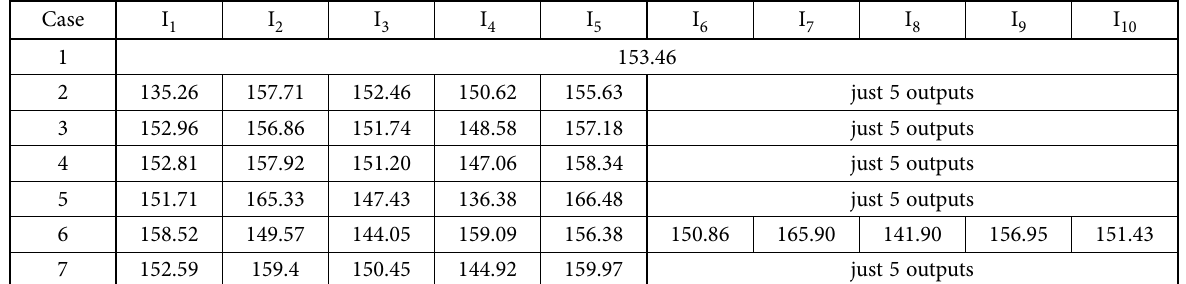
Table 3. Summary of CSI mod values obtained per